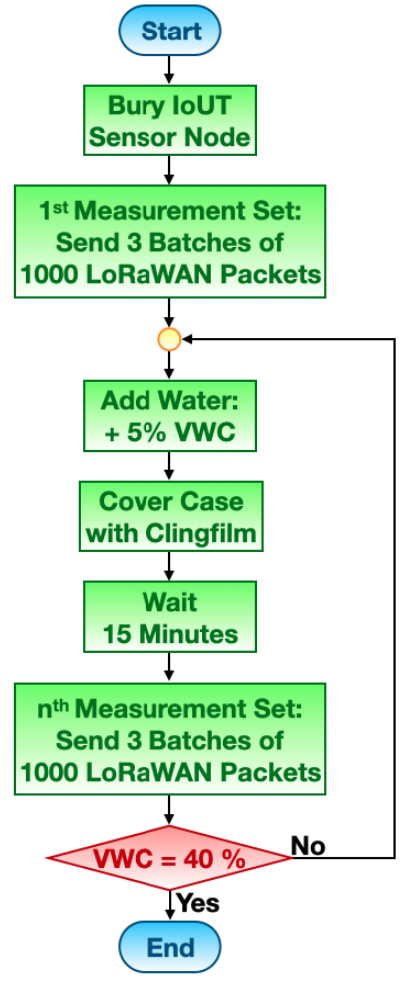
Figure 6. Flowchart of the adopted